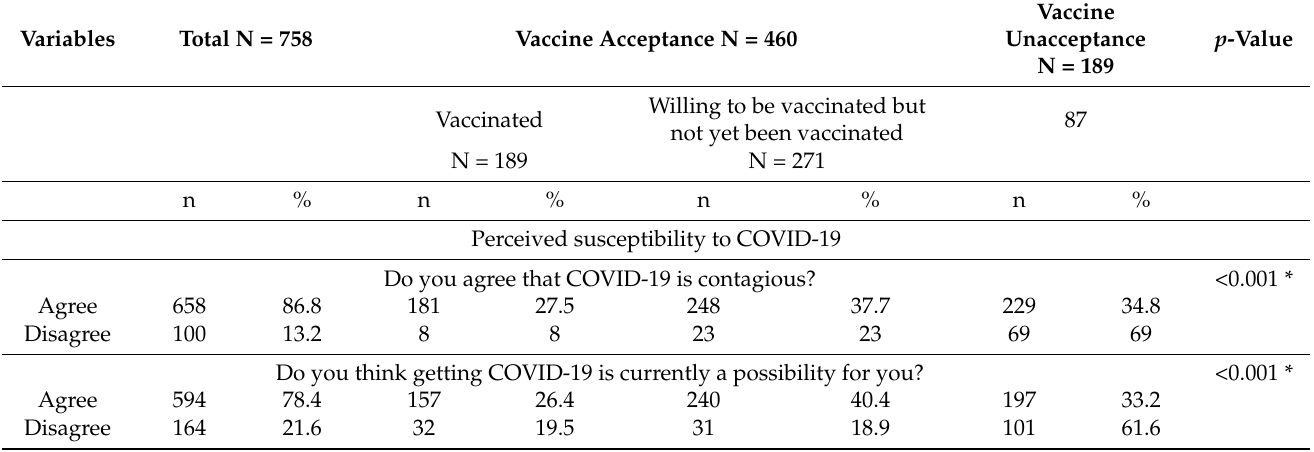
Table 2. Health benefit model characteristics and p -values of the